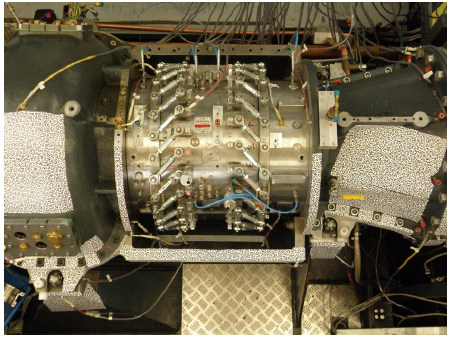
Figure 1. Axial compressor rig at